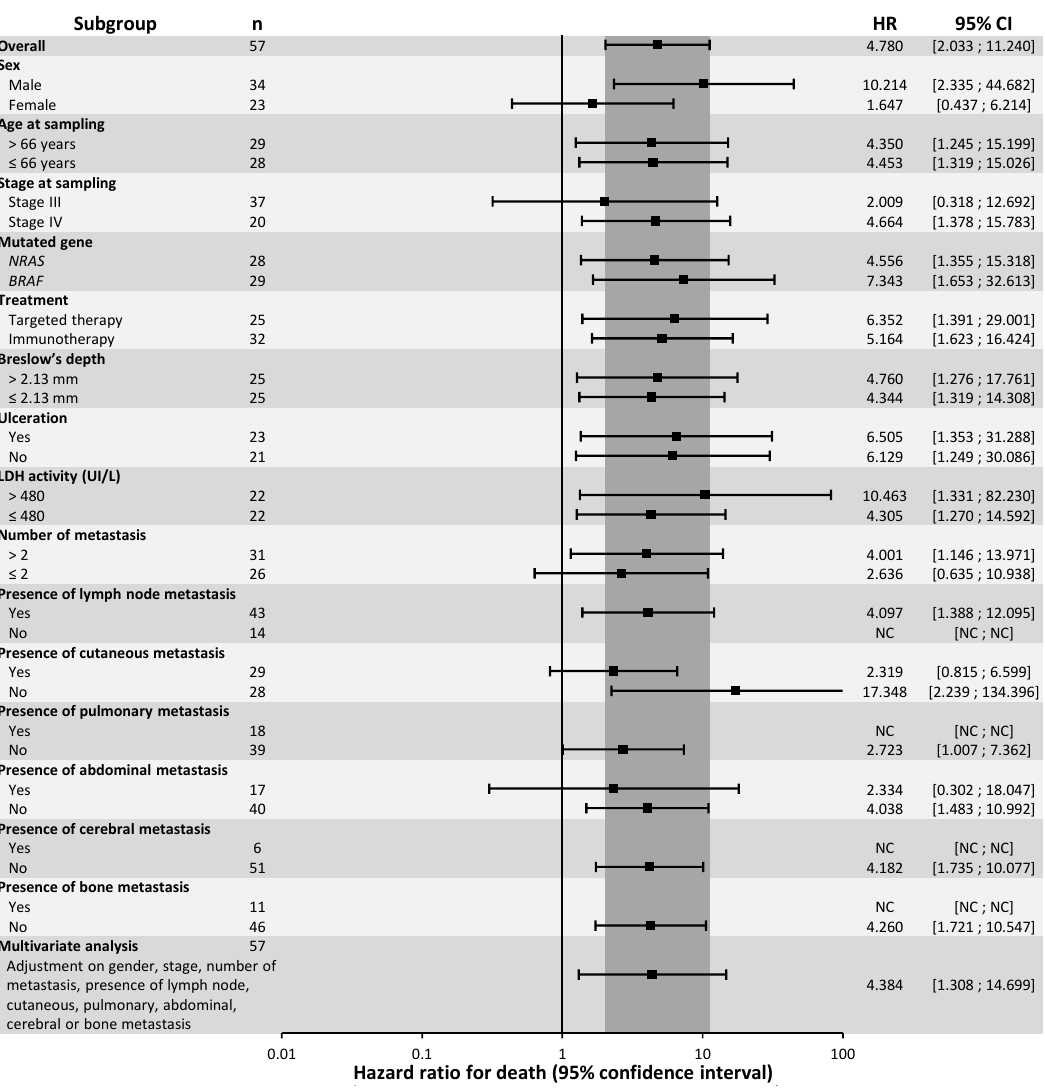
Figure 3. Subgroup and multivariate analysis of Overall Survival, according to ctDNA detectability.